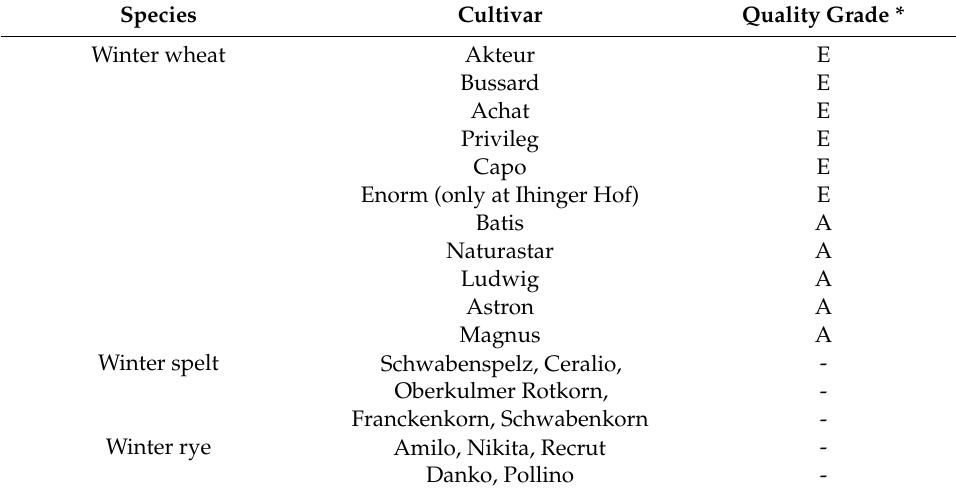
Table 3. Cereal species and cultivars tested in the field trials.